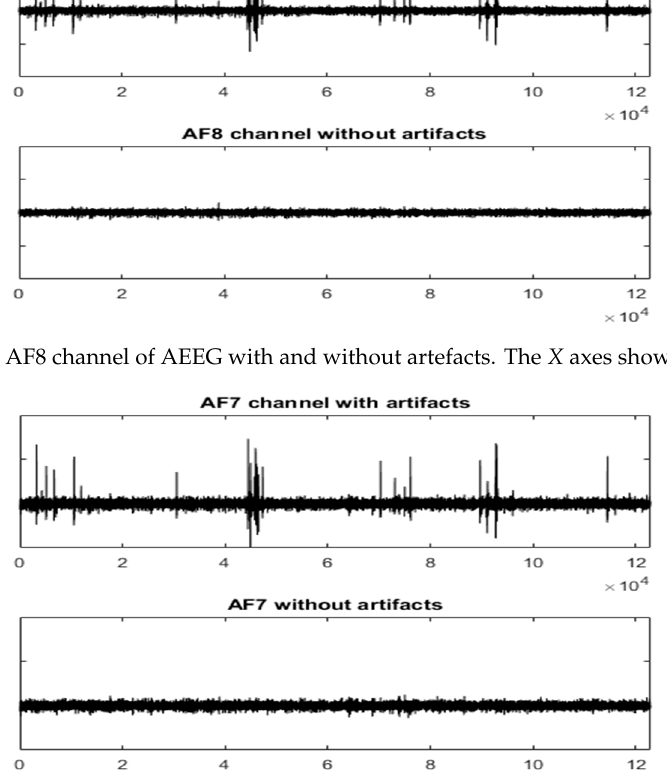
Figure 10. The undetected artefact in the EEG portion [37,500 39,800] of the channels AF8 and AF7. 5.2. Filtering an AEEG using MARA The EEGLAB is an interactive toolbox for processing electrophysiological data incorporating ICA and artefact rejection. This toolbox presents some extensions for artefact removal, for example, the MARA extension [17]. MARA is a linear classifier that learns from expert ratings by extracting six features from the spatial, the spectral and the temporal domains. This classifier and UAR pursue the same objectives. However, MARA is a supervised method. In this section, we compare UAR with MARA using the AEEG described in Section 3.1. Instead of creating a new metric, both methods will be visually compared. Figure 11 shows the EEG signal in the AF8 channel after using the MARA method. When comparing Figures 8 and 11, it is observed that UAR performs better for some important artefacts (see the red arrows). However, MARA is able to filter the small artefact near sample 40,000. Figure 11. The AF8 channel of AEEG after using the MARA method. The red arrows point to some artefacts that have not been well filtered.